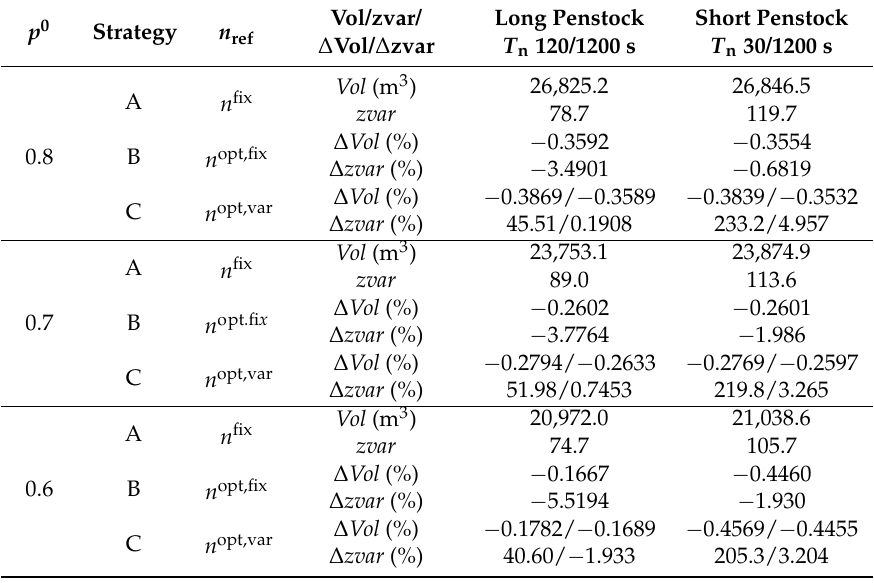
Figure 9. Running speed and reference speed with the three strategies. Short penstock configuration, p 0 = 0.7 p.u., h c0 = 1.131 p.u., scenario 1.